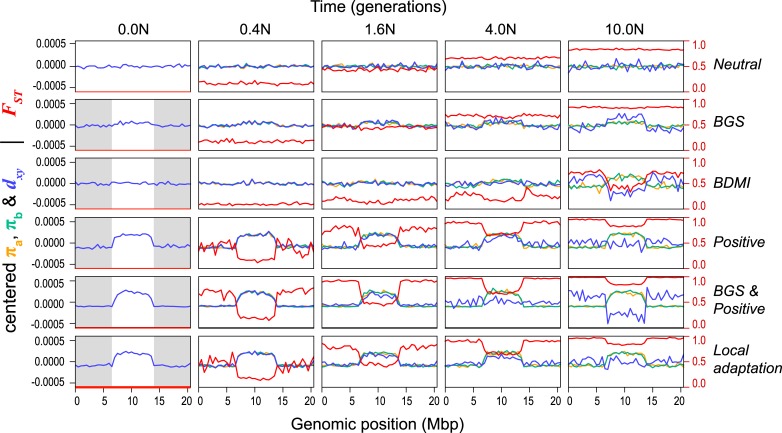
Genomic landscapes simulated under different divergence histories.Each row of plots shows patterns of within- and between-population variation (π, dxy, and FST) across the chromosome (500-kb windows) at 5 time points (N generations, where N = 10,000) during one of the scenarios The selection parameter (Ns, where s = Ns/N), proportion of deleterious (−) and positive mutations (+), and number of migrants per generation (Nm; 0 unless stated) for these simulations are as follows: (i) neutral divergence (no selection), (ii) BGS (−Ns = 100; −prop = 0.1), (iii) BDMI (−Ns = 100, −prop = 0.05, Nm = 0.1), (iv) positive selection (+Ns = 100, +prop = 0.001), (v) BGS and positive selection (−Ns = 100, −prop = 0.1; +Ns = 100, +prop = 0.005), and (vi) local adaptation (+Ns = 100, +prop = 0.001, Nm = 0.1). The gray boxes in the first column show the areas of the chromosome that are experiencing selection, while the white central area evolves neutrally. Note that π (in populations a and b) and dxy have been mean centered so they can be viewed on the same scale. Uncentered values and additional simulations with different parameter combinations and more time points can be found in S13 Fig. BDMI, Bateson-Dobzhansky-Muller incompatibility; BGS, background selection.